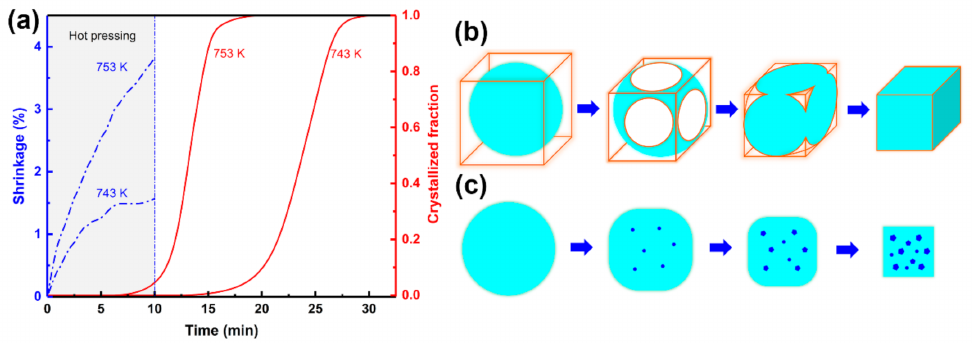
Figure 7. ( a ) Shrinking curves as a function of the holding time for the isothermal stage of hot pressing (represented by the shadowed area) of the Zr 48 Cu 36 Al 8 Ag 8 powder at 743 and 753 K along with the crystallized fractions derived from the areas of the corresponding isothermal DSC peaks in Figure 4b. Note that the curves are shifted so that the isothermal stage starts at 0 min for both experiments. The vertical dashed line represents the time when the pressure was released. ( b ) Schematic representing the variation of contact area for a particle in an ensemble of particles with cubic packed structure and corresponding to the shrinking curves in ( a ). The sphere is progressively deformed, increasing the contact area (white circles). ( c ) Schematic representation of glass crystallization accompanying the sintering process, corresponding to the blue curves in ( a ). Crystals embedded in the glassy matrix are represented as dark blue pentagons.